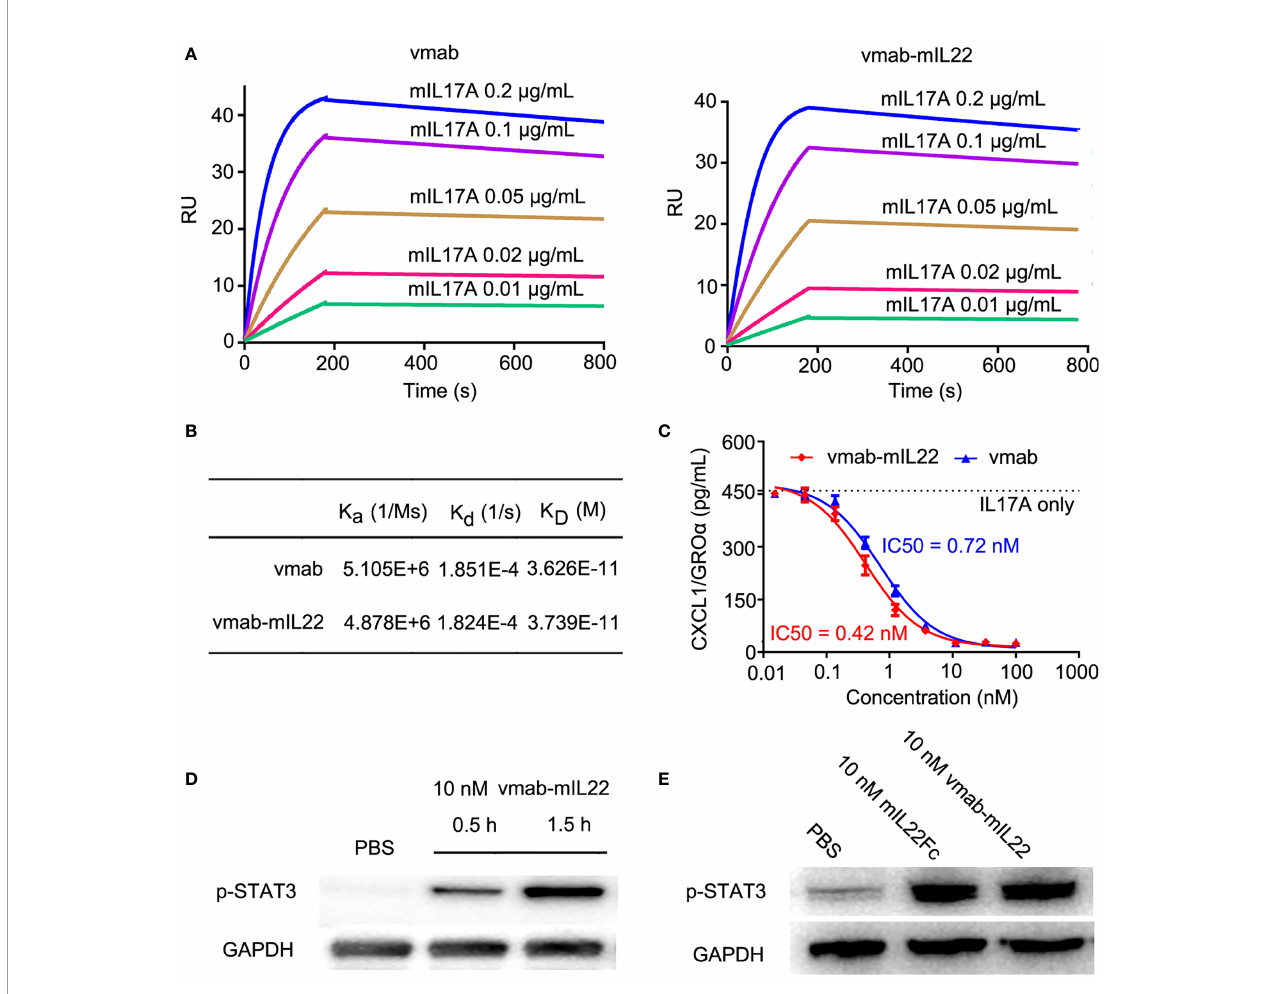
FIGURE 3 | vmab-mIL22 exhibits dual functionality, and the functional integrity of the cytokine payloads is preserved. (A, B) Biacore sensorgrams of the interaction of vmab with mIL17A and BIAcore sensorgrams of the interaction of vmab-mIL22 with mIL17A. vmab-mIL22 retained a high af fi nity for the cognate antigen, similar to that of the parental antibody Vmab, which was con fi rmed by surface plasmon resonance analysis. Sensorgrams display the response values at IL17A concentrations of 0.01 to 0.2 m g/mL, with a CM5 chip and capture with 100 RU vmab or vmab-mIL22. The equilibrium dissociation constant (K D ) was calculated using k d /k a for each measurement. k d , dissociation rate constant or off-rate constant; k a , association rate constant or on-rate constant. Binding was biphasic, and the data were fi t with heterogeneous ligand models. (C) In vitro inhibition of functional activity by vmab-mIL22. Inhibition of Gro a release from HT-29 cells as a measure of IL-17A inhibition. HT29 cells were stimulated with IL-17A (5 nM) in the presence of various concentrations of vmab-mIL22. vmab was used as a positive control. Gro a levels in the supernatants were measured by ELISA from R&D systems. (D) Western blot analysis of STAT3 phosphorylation (p-STAT3) induced by 10 nM vmab-hIL22 in HepG2 cells at different times. (E) Western blot analysis of STAT3 phosphorylation (p-STAT3) induced by 10 nM mIL-22Fc or vmab-mIL22 in HepG2 cells at 1.5 h Serum-starved cells (3×10 6 /mL) were stimulated with PBS, 10 nM mIL22-Fc or Vmab-mIL22 for 1.5 h at 37°C. Whole-cell lysates were resolved on denaturing gels, transferred, and immunoblotted with a polyclonal anti-phospho-STAT3